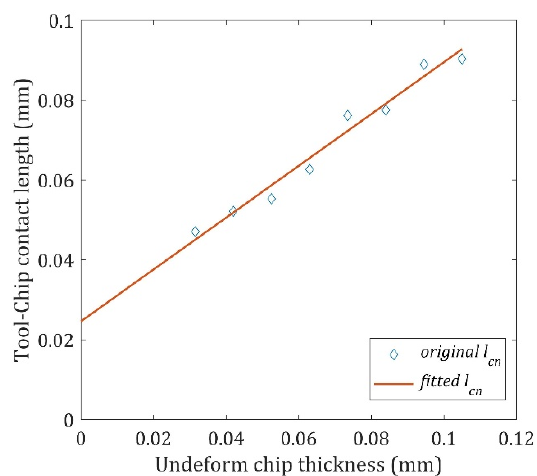
Figure 4. The relationship between the un ‐ deformed chip thickness h and contact length l cn .